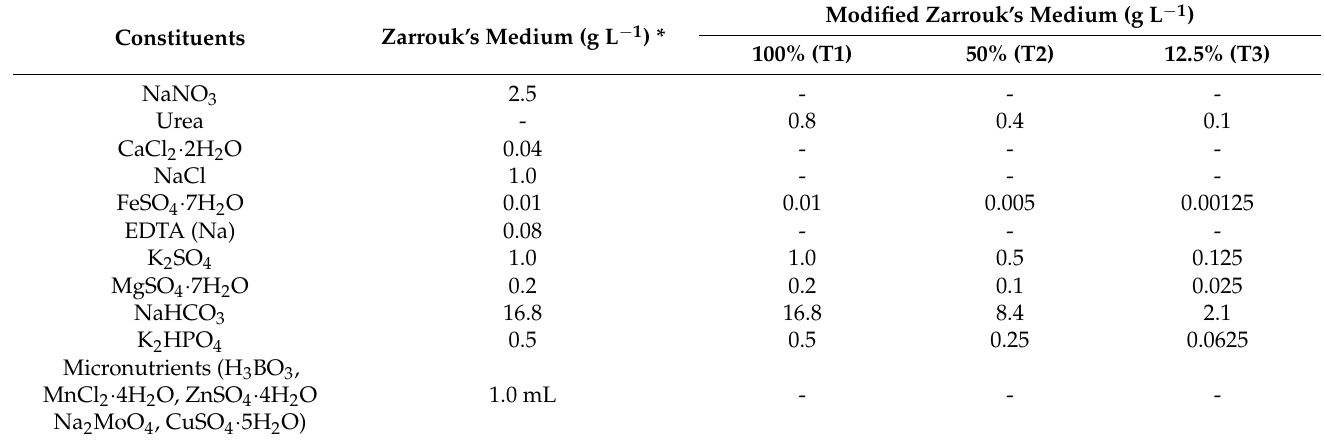
Table 1. The modified Zarrouk’s medium chemical composition (g L − 1